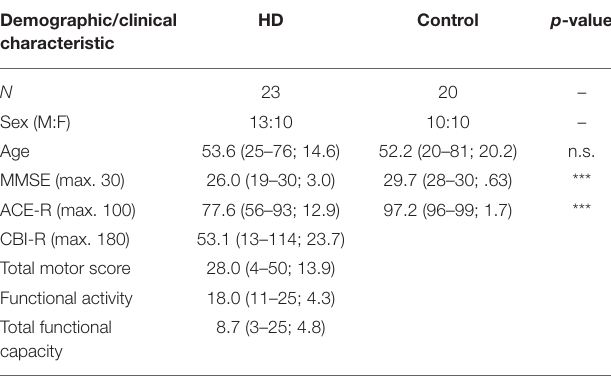
TABLE 1 | Demographic and clinical characteristics of human participants. Demographic/clinical